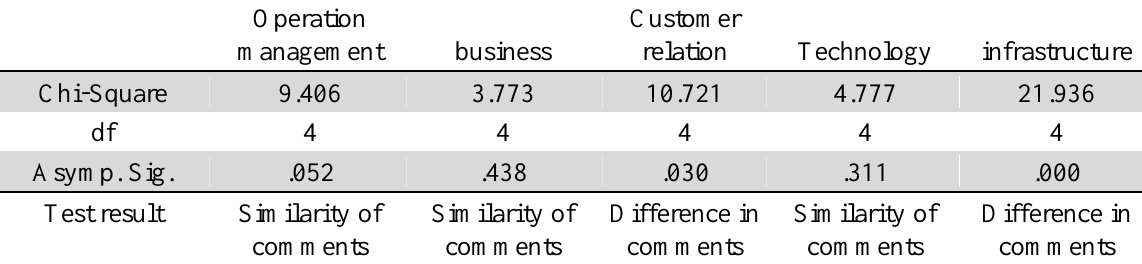
The results of Kruskal-Wallis